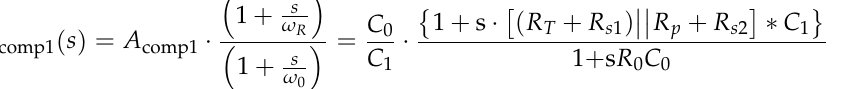
Figure 9. ( a ) The structure of compensation circuit for pole frequencies. ( b ) The structure of compensation circuit for sensitivity coefficient. ( c ) The image of the circuit board and thermistors.